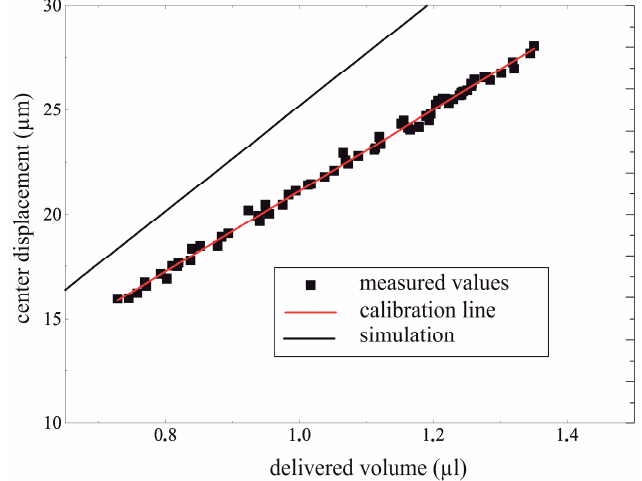
Figure 16. Simulated line and measured values fitted with a calibration